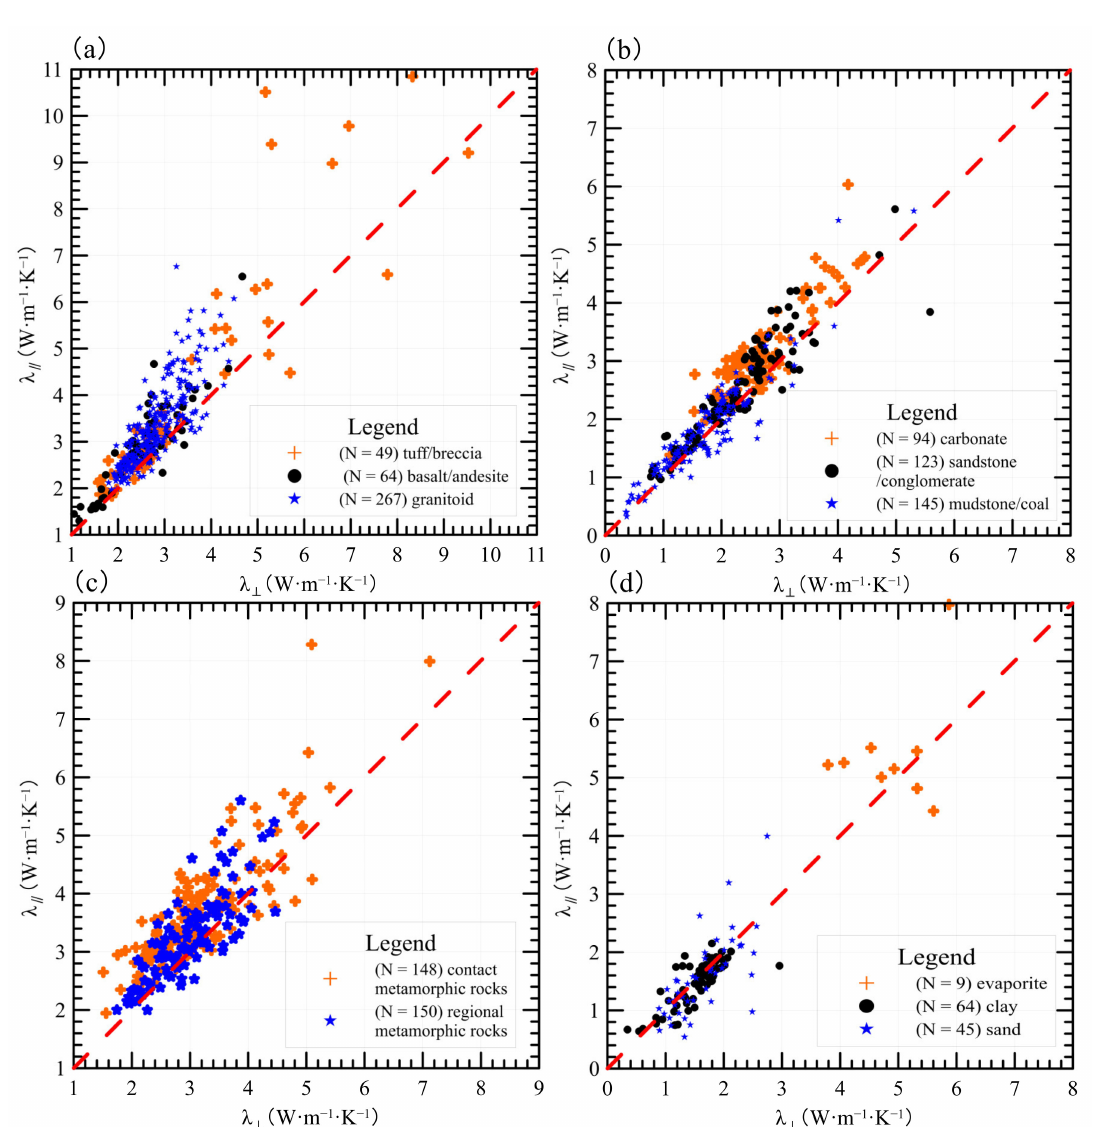
Figure 3. Statistical analysis of anisotropy of thermal conductivity of different rock types: ( a ) tuff/breccia, basalt/andesite, and granitoid; ( b ) carbonate, sandstone/conglomerate, and mudstone/coal; ( c ) contact metamorphic rocks, regional metamorphic rocks; ( d ) evaporate, clay, and